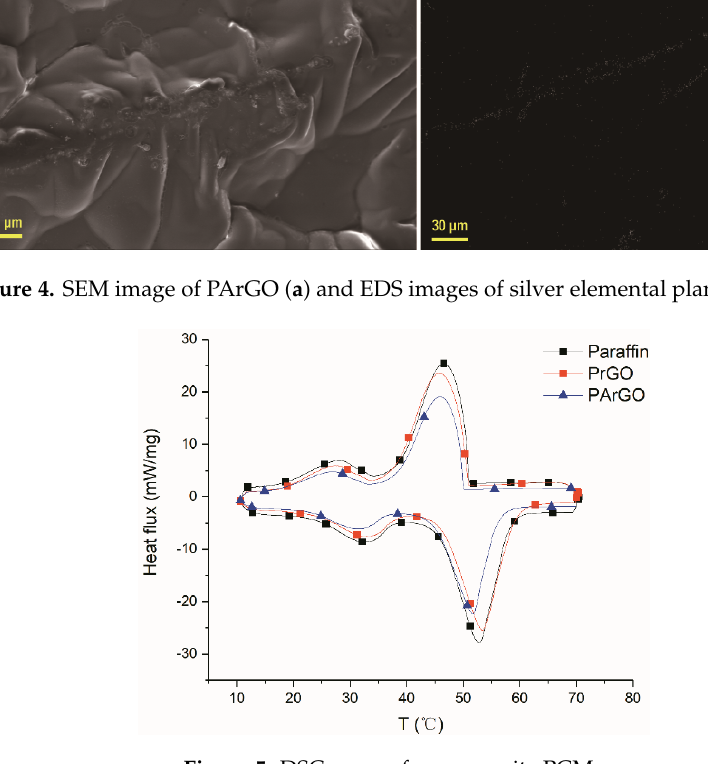
Figure 5. DSC curves for composite PCMs.